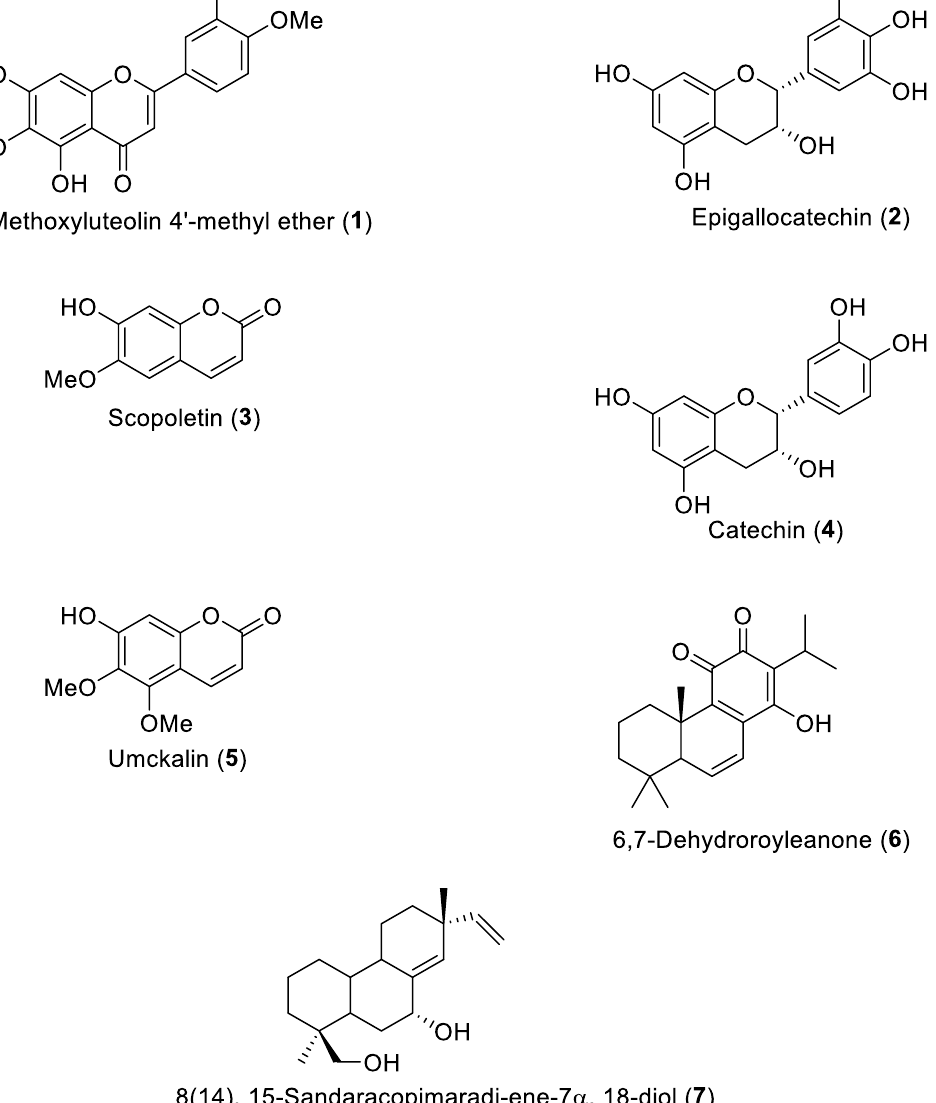
Figure 3. Antimycobacterial tuberculosis compounds isolated from plants used against tuberculosis in Mpumalanga Province. The numbers 1 to 7 correspond to the compound reported in Table 2.